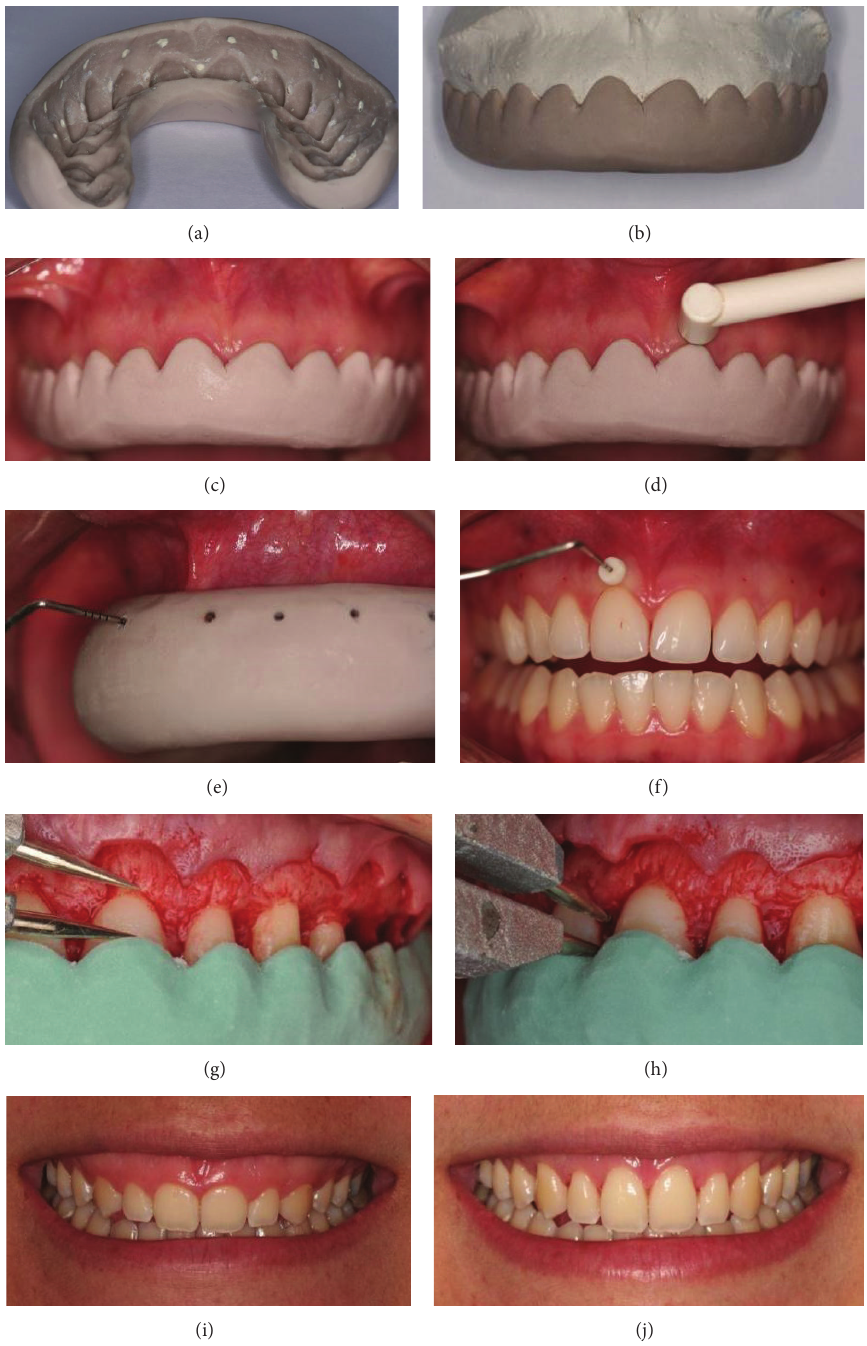
Figure 1: (a) Tomographic guide showing the marks made at the tip of each interproximal papilla and 3.0 mm above the gingival margin of each tooth. (b) Clinical guide following the contours of the gingival margin and the tips of the interproximal papillae. (c) Positioning the clinical guide to measure gingival thickness (GT) using ultrasound (US). (d) Positioning the US to measure GT. (e) Marking the point to measure GT. (f) Silicon limiter in contact with the external surface of the gum to measure GT. (g) Measuring the distance between the gingival margin and the vestibular bone crest (GMBC-V) at the highest point from the clinical guide margin to the vestibular bone crest. (h) Measuring the distance between the gingival margin and the interproximal bone crest (GMBC-I) from the point in the clinical guide which represents the tip of the interproximal papilla to the interproximal bone crest. (i) Patient’s gummy smile. (j) Patient’s smile after